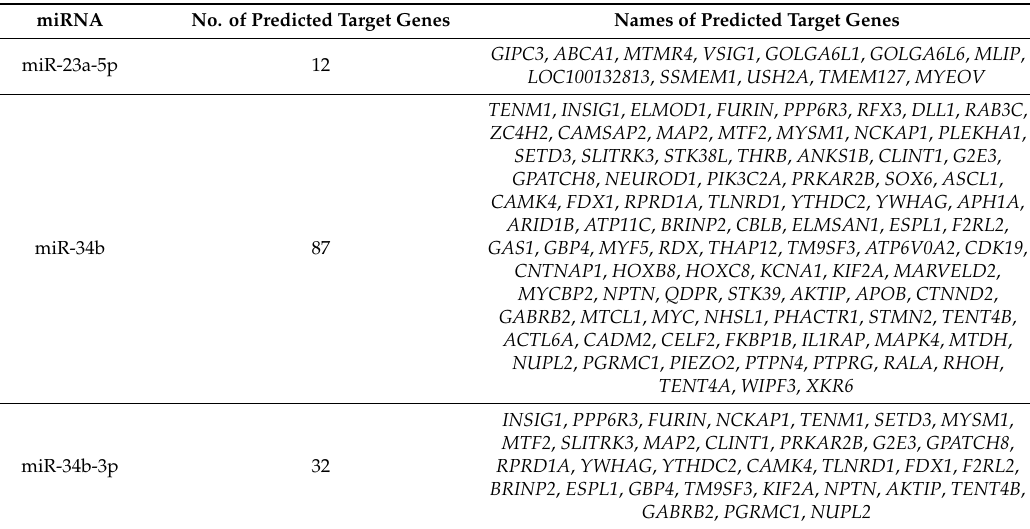
Table 1. List of predicted target genes of di ff erentially expressed miRNAs (False Discovery Rate (FDR) < 0.05 and ≥ 2.0-Fold Change (FC) or ≤− 2.0-FC) in explant media from uterus and utero-tubal junction (UTJ) exposed to di ff erent treatments (Medium 199 (M199) supplemented with seminal plasma from di ff erent ejaculate fractions (sperm-rich fraction (SRF) and post-SRF), and from the entire recomposed ejaculate (EE)) compared with its control (C, M199